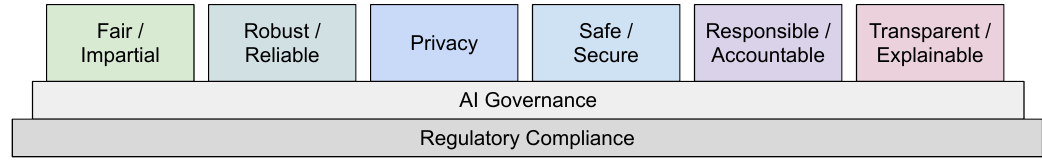
Figure 3. The pillars of the trustworthy artificial intelligence (AI) framework (see